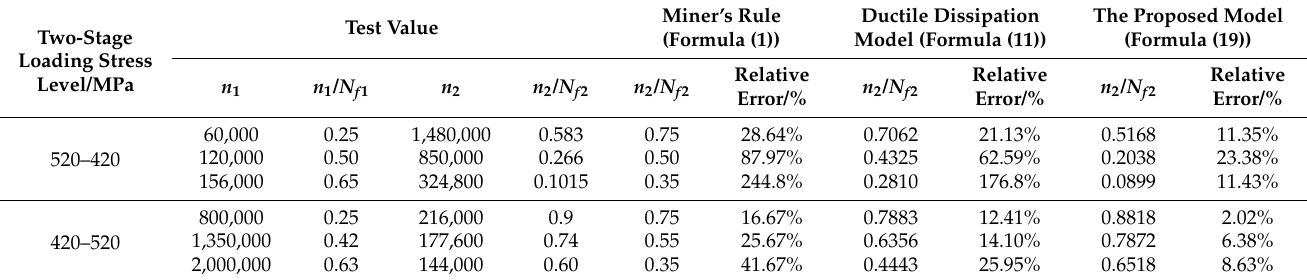
Table 4. 18CrNiMo7-6 two-stage loading test data and the remaining life prediction results of each model. Two-Stage Loading Stress Level/MPa